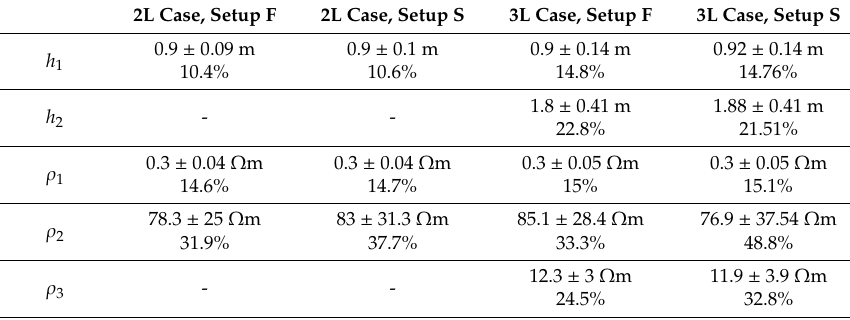
Table 5. Expected model and variance calculated from all models saved during the stochastic inversion usingsixiterationsteps. Thesubsurfaceparameters’layerthickness h i andresistivity ρ i aredistinguished for the 2L and 3L case as well as for setup F and setup